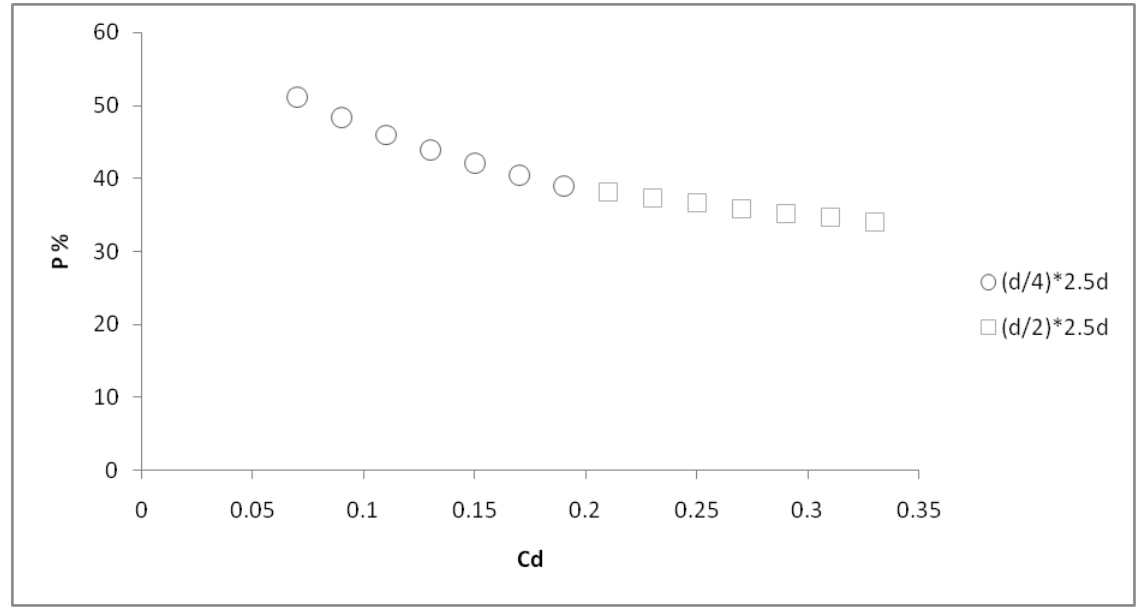
Fig. 3 The best performance of the anti-vortex plates used in present